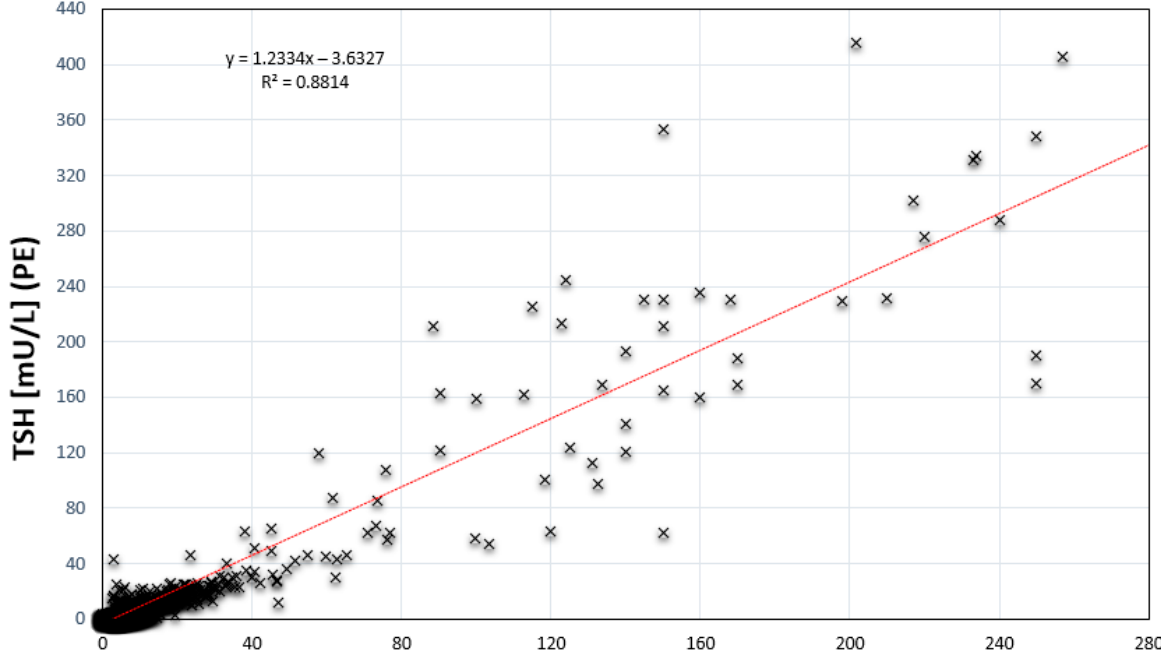
Figure 1. Comparison of TSH determination by Labsystems/NS2400 and PerkinElmer/GSP ( n = 5029).